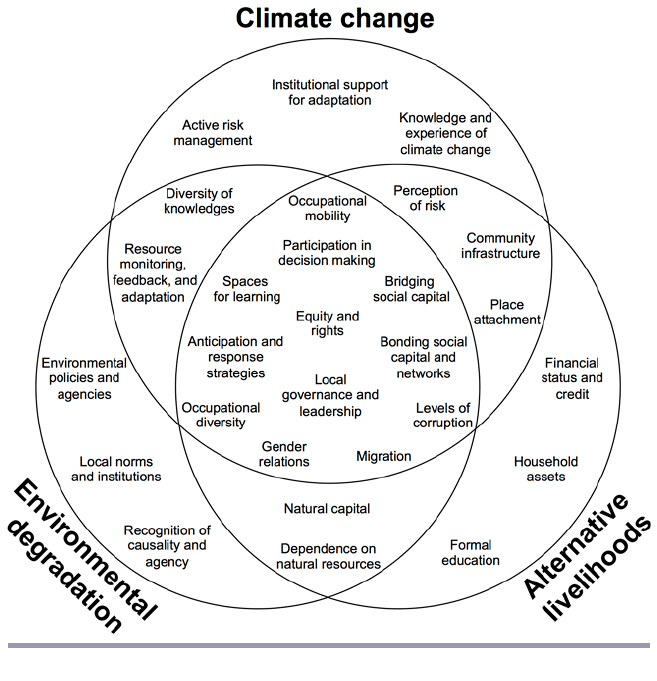
Fig. 1 . Contribution of components to community adaptive capacity to climate change, environmental degradation, and alternative livelihoods.